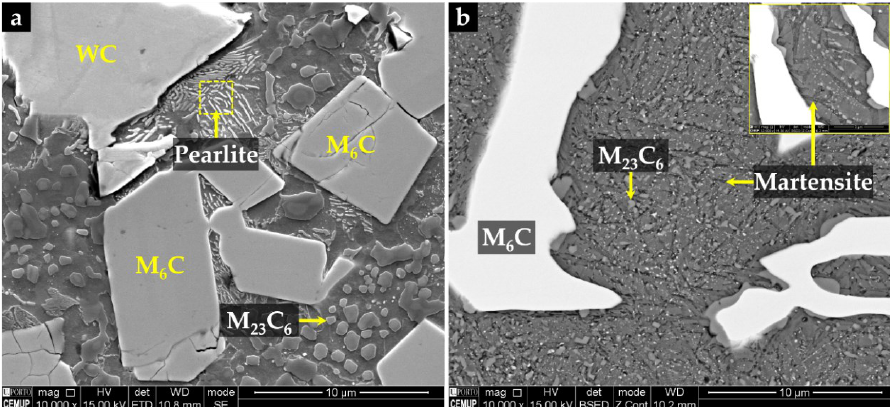
Figure 5. SEM–SE image of the CZ1, showing the α matrix with small colonies of lamellar pearlite and globular precipitation of (Fe,W) 23 C 6 ( a ); and SEM–BSE image of the CZ3, evidencing the matrix of martensite, revealed with Vilella’s reagent, with a fine precipitation of (Fe,W) 23 C 6 ( b ).